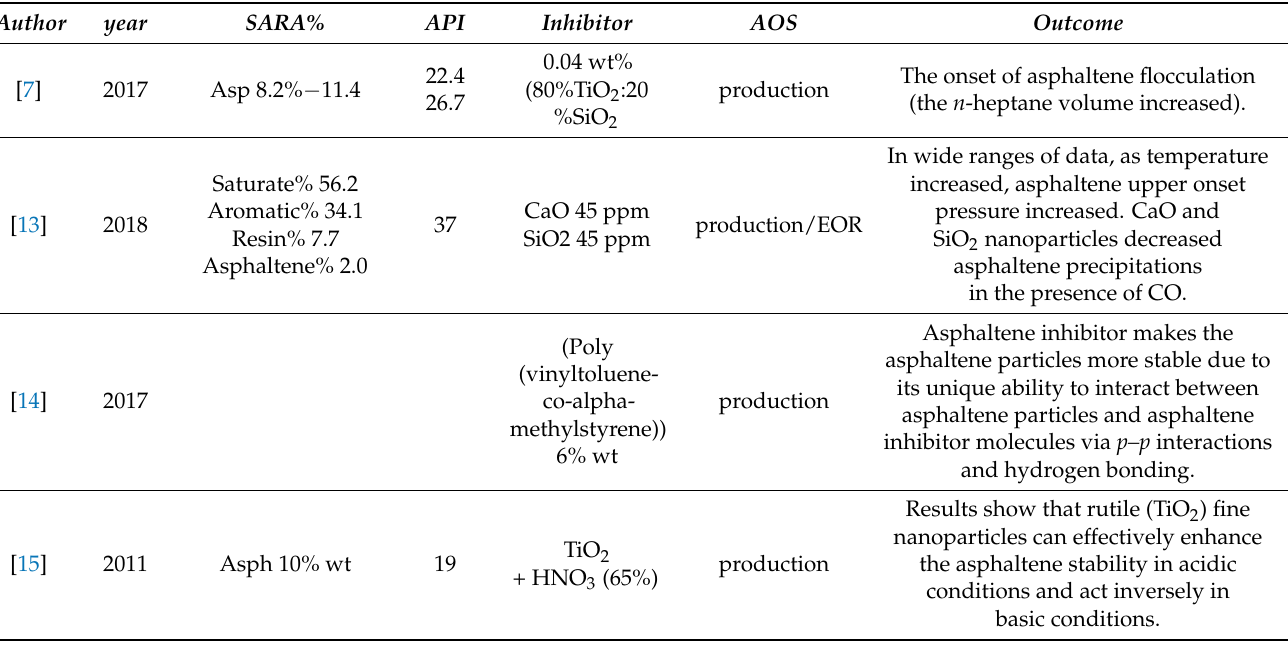
Figure 1. Asphaltene molecule surrounded by Nanoparticles [10]. Table 1. Uses of asphaltene Nano Inhibitors in literature.